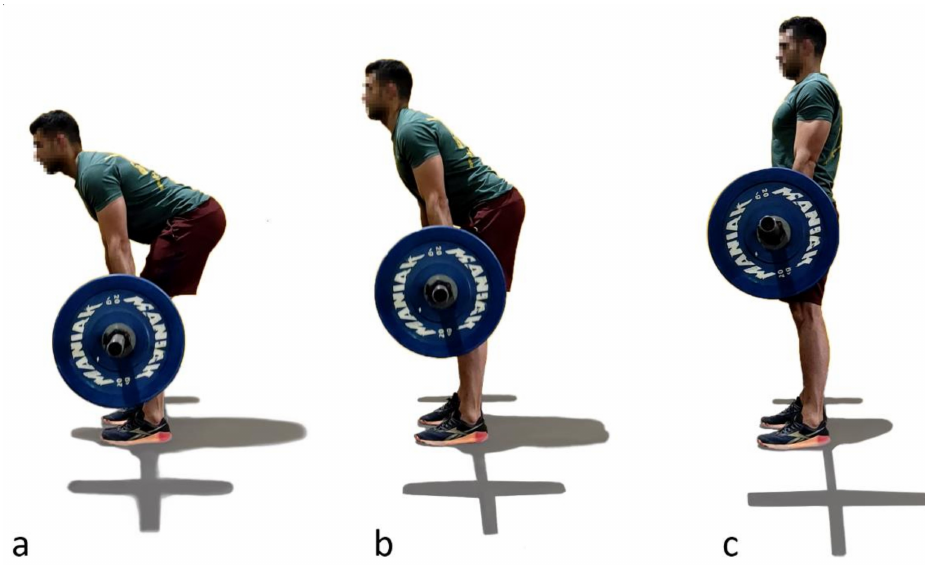
Figure 3. Deadlift technique. ( a ): Step 1; ( b ): Step 2; ( c ) Step